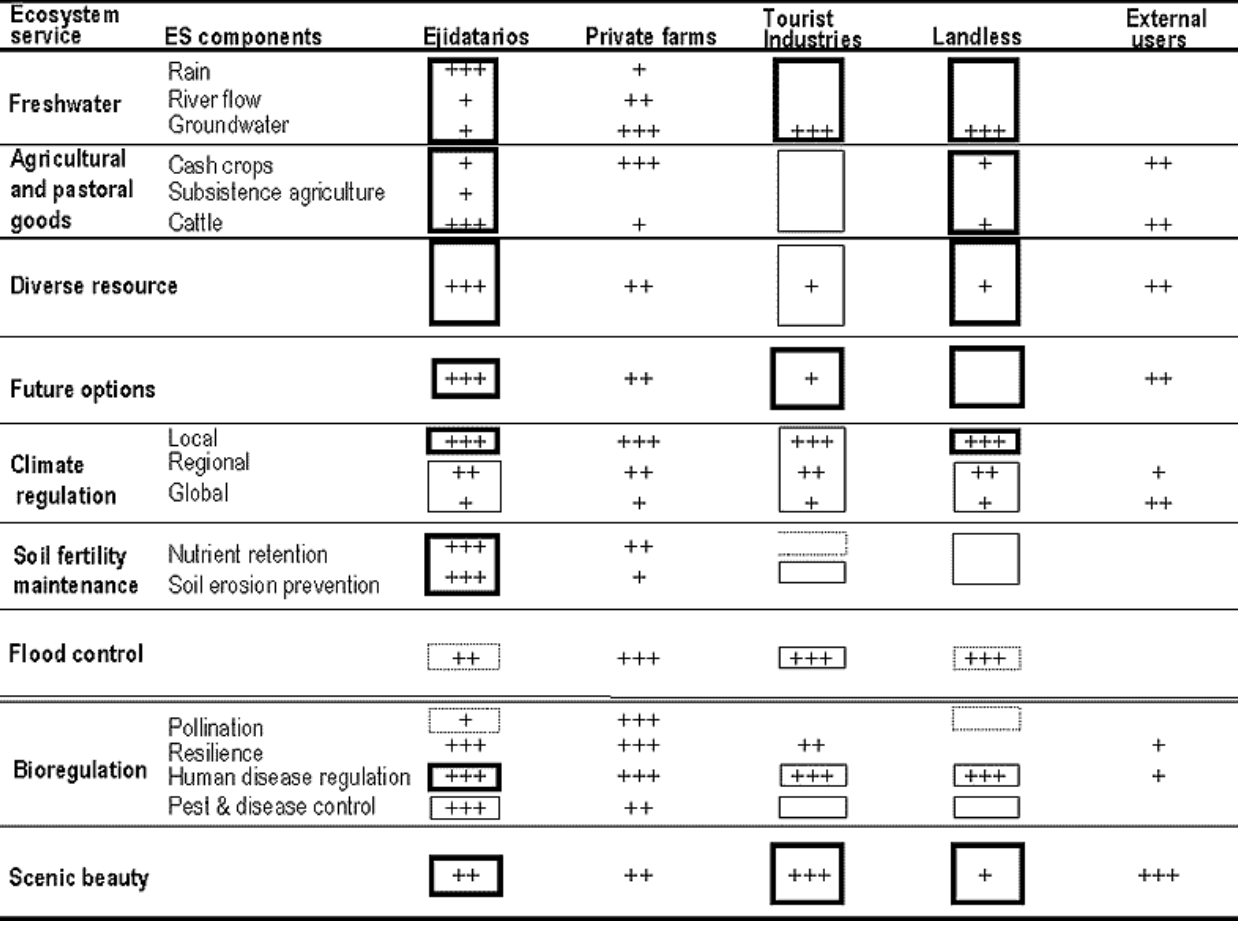
Fig. 4. Relationship between ecosystem services delivered by a tropical dry forest region of western Mexico and the stakeholders who benefit from those services. Benefits to stakeholders from a scientific perspective were qualitatively divided as slightly benefited (+), moderately benefited (++), and clearly benefited (+++). For each service, different components were evaluated separately. Stakeholders’ awareness of how they benefit from each service is shown by the presence of a box; it was qualitatively evaluated as: widely acknowledged (solid lines), little acknowledged (narrow lines), or never acknowledged (dashed lines). Data on awareness are only available for ejidatarios, tourism industries, and landless